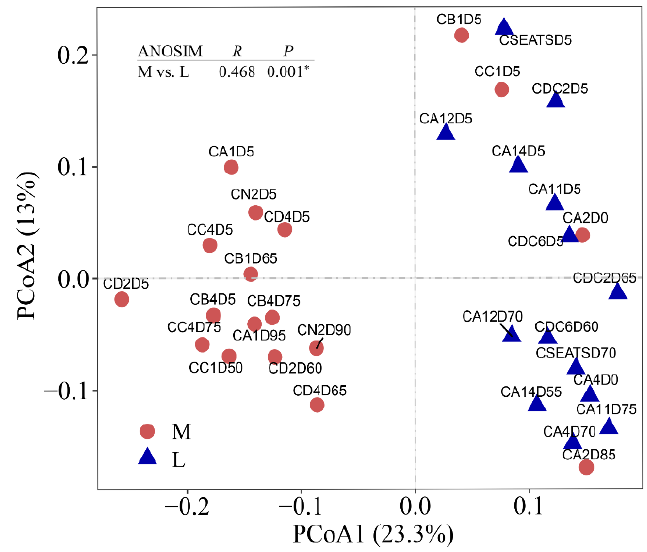
Figure 2. Bray–Curtis principal coordinate analysis (PCoA) plot illustrated the ciliate community distribution across the South China Sea, with analysis of similarity (ANOSIM) R and p values nested on the cage.